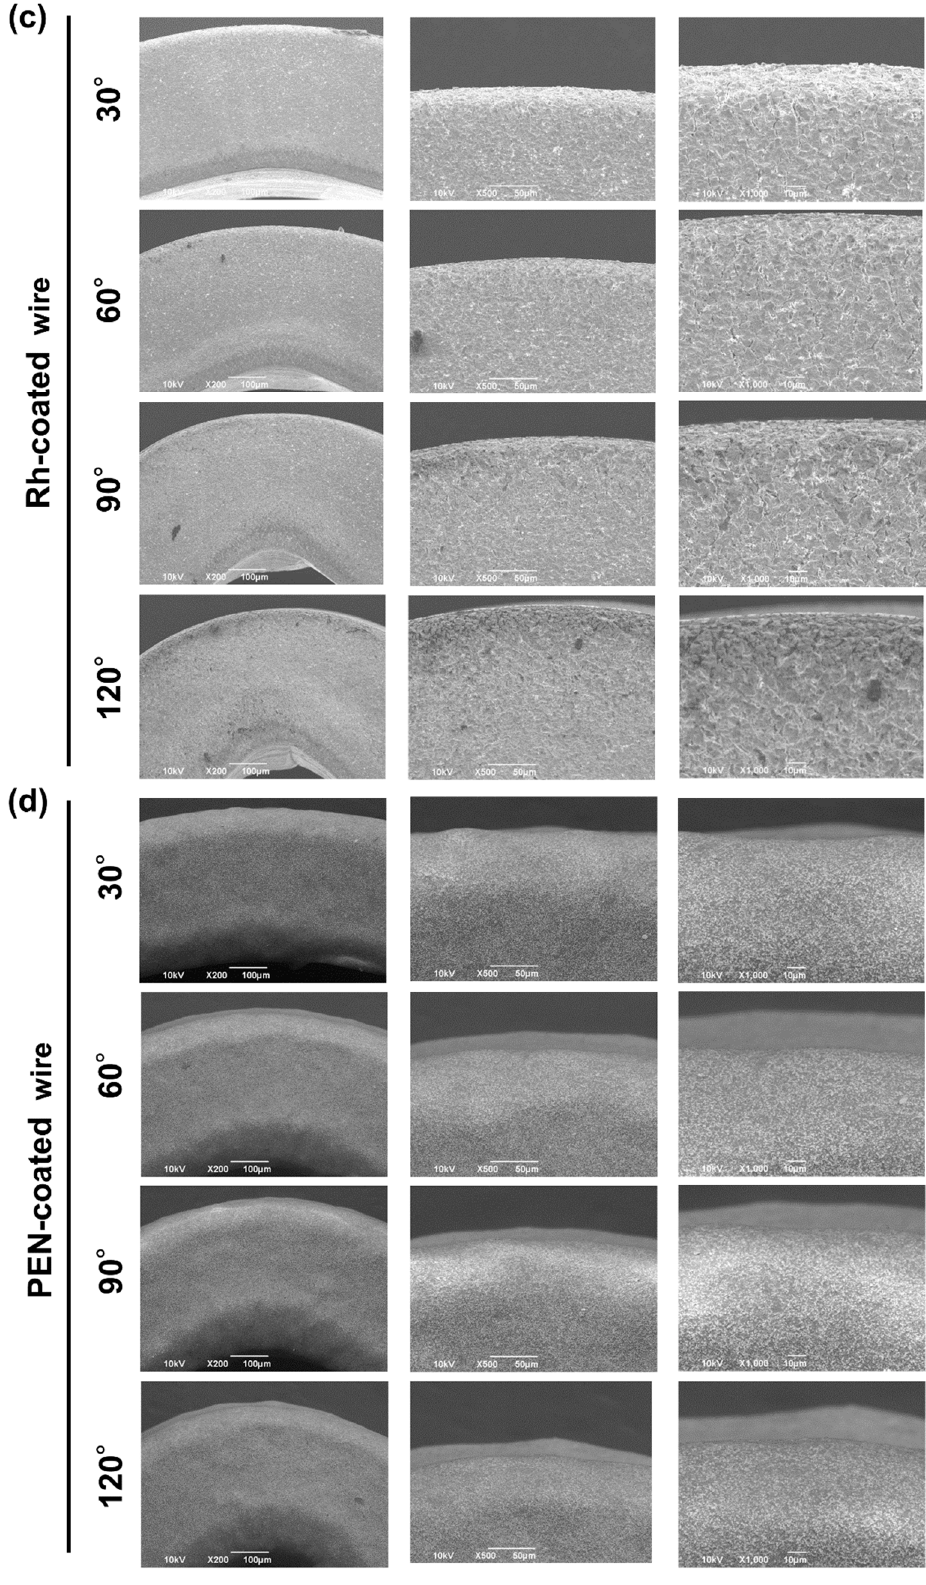
Figure 4. Scanning electron micrographs of four types of coated wire with various bend angles from 30° to 120° (×200 ×500 ×1000): ( a ) TiN-coated wire; ( b ) Au-coated wire; ( c ) Rh-coated wire; ( d ) PEN-coated wire.